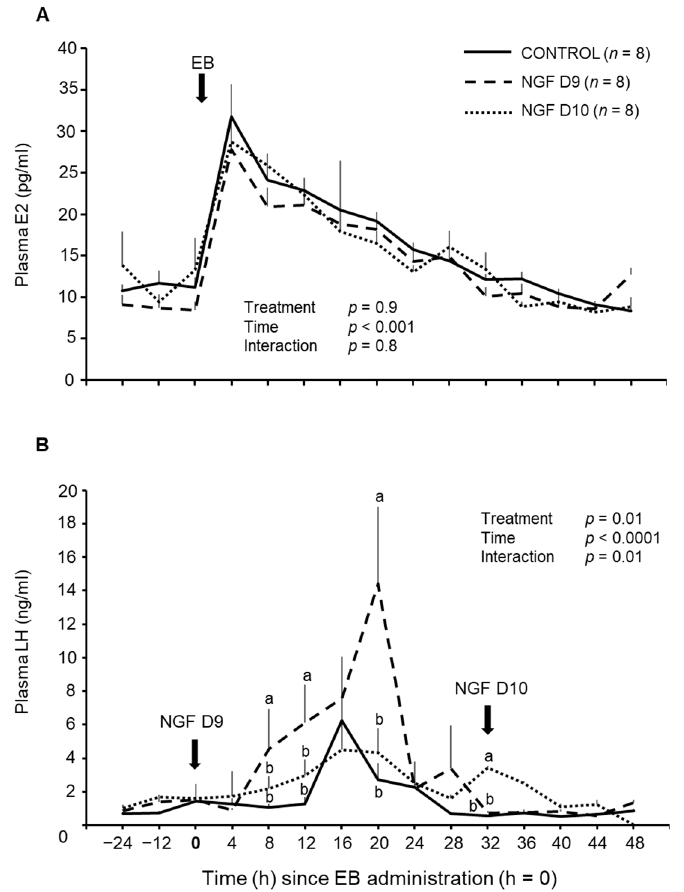
Figure 3. Plasma ( A ) E2 and ( B ) LH concentrations in heifers synchronized with an E2/P4-based, timed AI protocol and treated with PBS (control), NGF D9, or NGF D10. Data are centralized to the day of second EB administration. Values are mean ± SEM; values with different superscripts between groups are different ( p < 0.01).